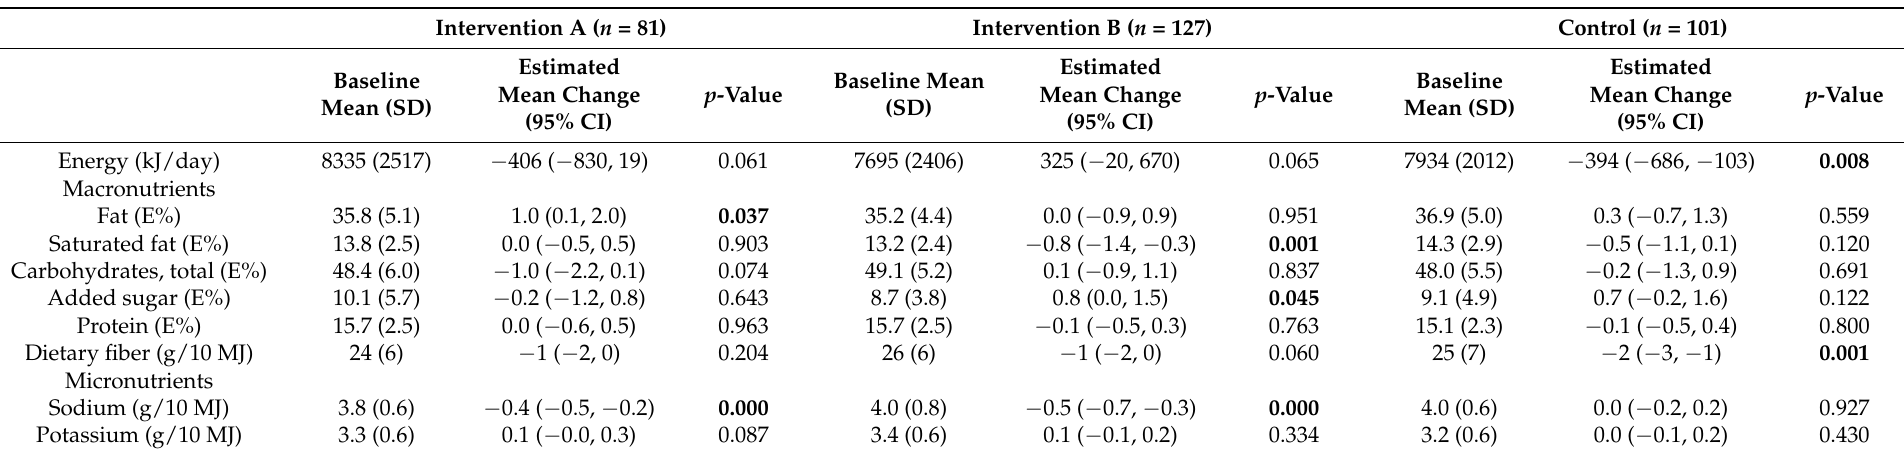
Table 5. Intake of energy and nutrients at baseline and estimated mean change from baseline to follow-up in the three groups (g/10